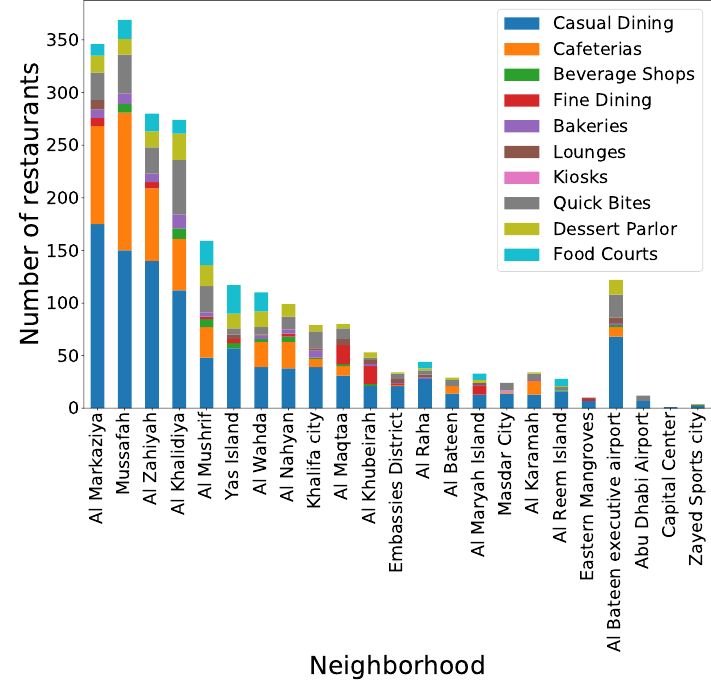
Figure 3. Distribution of restaurant types by